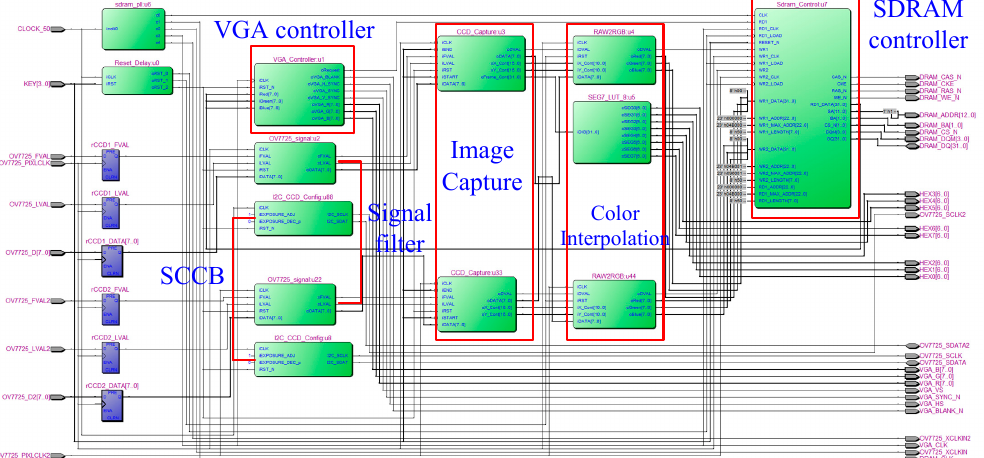
Figure 4. RTL-schematic diagram of the dual camera vision module.